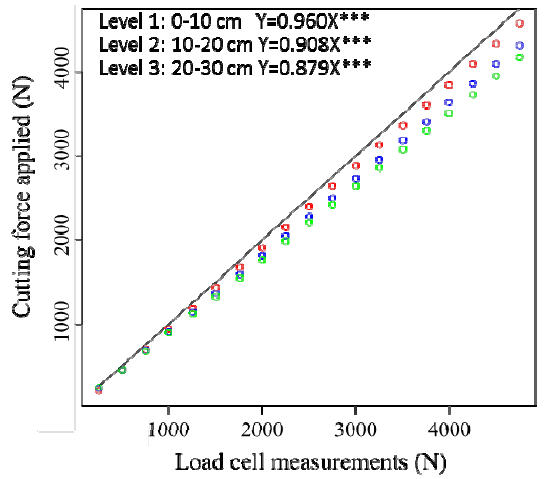
Figure 4. Scatter plot and fitted regression through the origin for the third steel blade. green